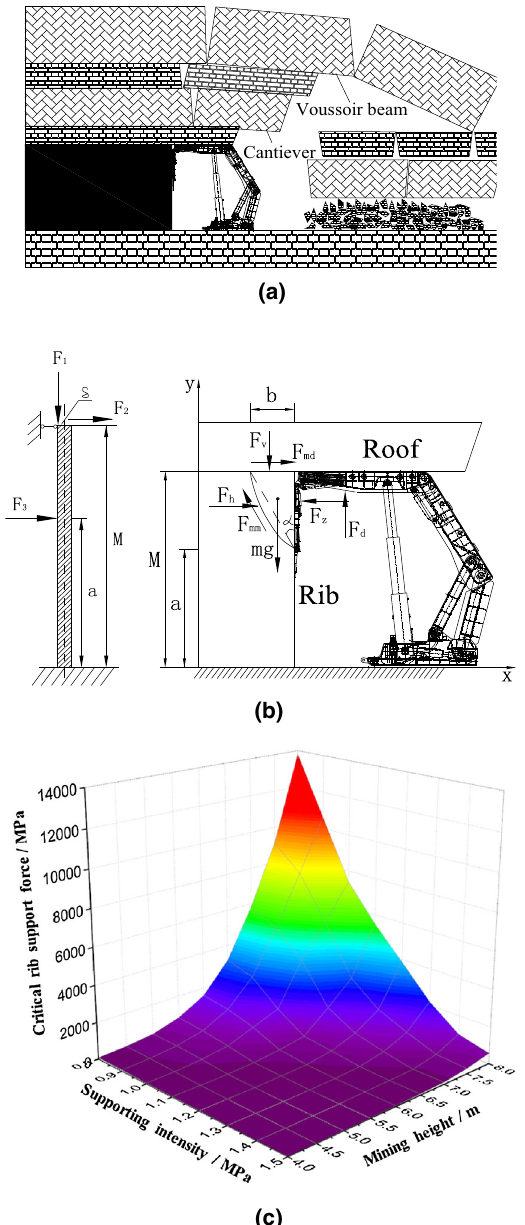
Fig. 4 Coupling mechanical model between hydraulic support and surrounding rock. a ‘‘Cantilever ? voussoir beam’’ structural mechanics model, b ‘‘Tension-slippage’’ mechanical model, c rela- tionship of supporting intensity and critical rib support force in different mining